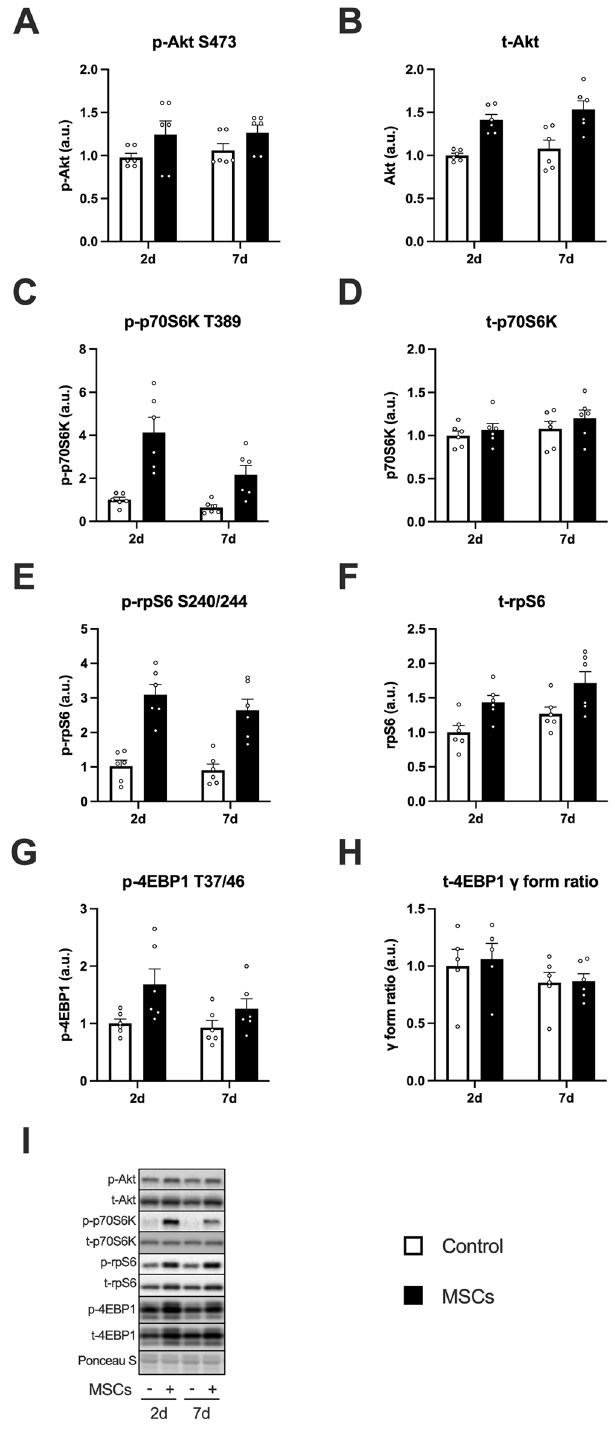
Figure 3. The expression of mTORC1 signal-related factors after intramuscular injection of MSCs. Protein expression of phosphorylated Akt (Ser473, A ), Akt ( B ), phosphorylated p70S6K (Thr389, C ), p70S6K ( D ), phosphorylated rpS6 (Ser240/244, E ), rpS6 ( F ), phosphorylated 4EBP1 (Thr37/46, G ), 4EBP1 gamma form ratio ( H ), and representative bands ( I ). Data are expressed relative to the control leg at 2 days post intramuscular injection of MSCs as the mean ± SE. Tendency or significant main effects of MSC were observed for phosphorylated Akt, Akt, phosphorylated p70S6K, p70S6K, phosphorylated rpS6, rpS6, and phosphorylated 4EBP1 (P = 0.0581, P < 0.0001, P < 0.001, P < 0.01, P < 0.0001, P < 0.001, and P < 0.001, respectively). A significant main effect of time was observed for phosphorylated p70S6K (P <